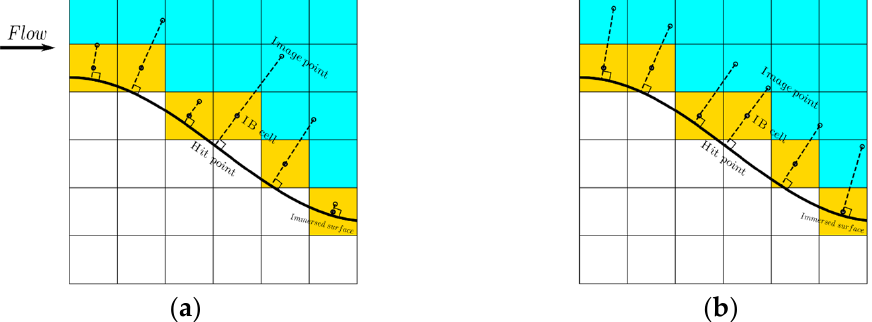
Figure 1b. The numerical instability due to the small value of (cid:1877) implementation has been used in [12] and [11] for the (cid:1863) − (cid:2033) model and SA model.